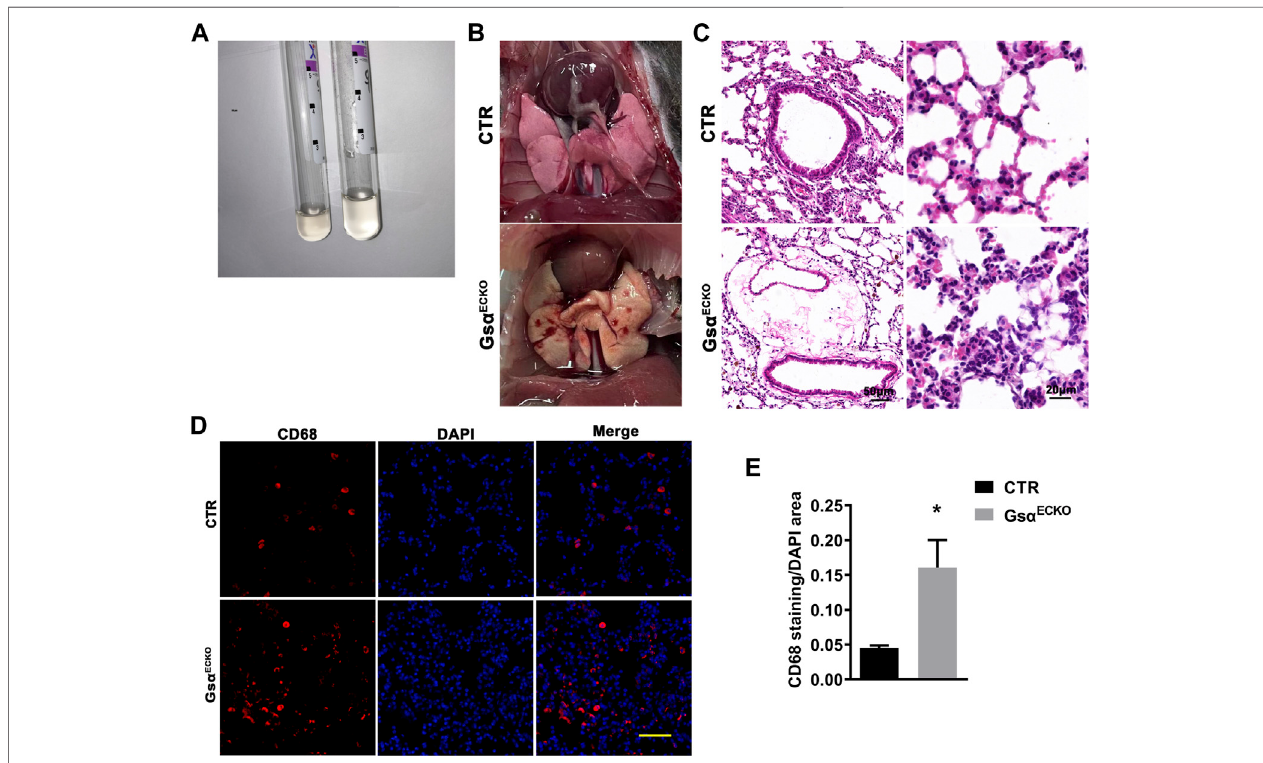
FIGURE 3 | The lung tissue of Gs α ECKO mice was in fi ltrated with in fl ammation. (A) Pleural effusion was sucked from the thoracic cavity. (B) Presence of petechiae on the pleural surface of Gs α ECKO mice lungs. (C) H&E staining of lung tissue sections from CTR and Gs α ECKO mice. Scale bar, 20 μ m. (D) Representative immuno fl uorescent staining of CD68 in lung tissues of CTR and Gs α ECKO mice. Scale bar, 100 μ m. (E) Quanti fi cation of CD68 positive area/DAPI area. n = 6 to 7 per group. Data are shown as mean ± SEM. * p < 0.05 between 2 indicated groups by 2-tailed Student